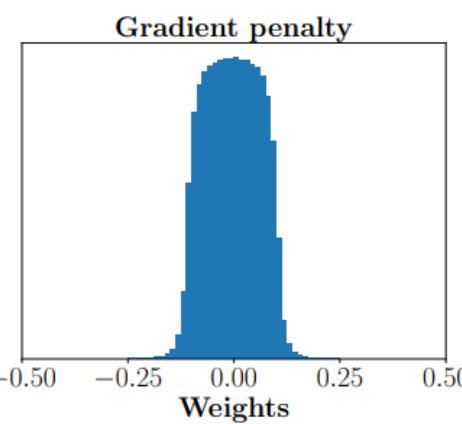
Figure 4. Gradient